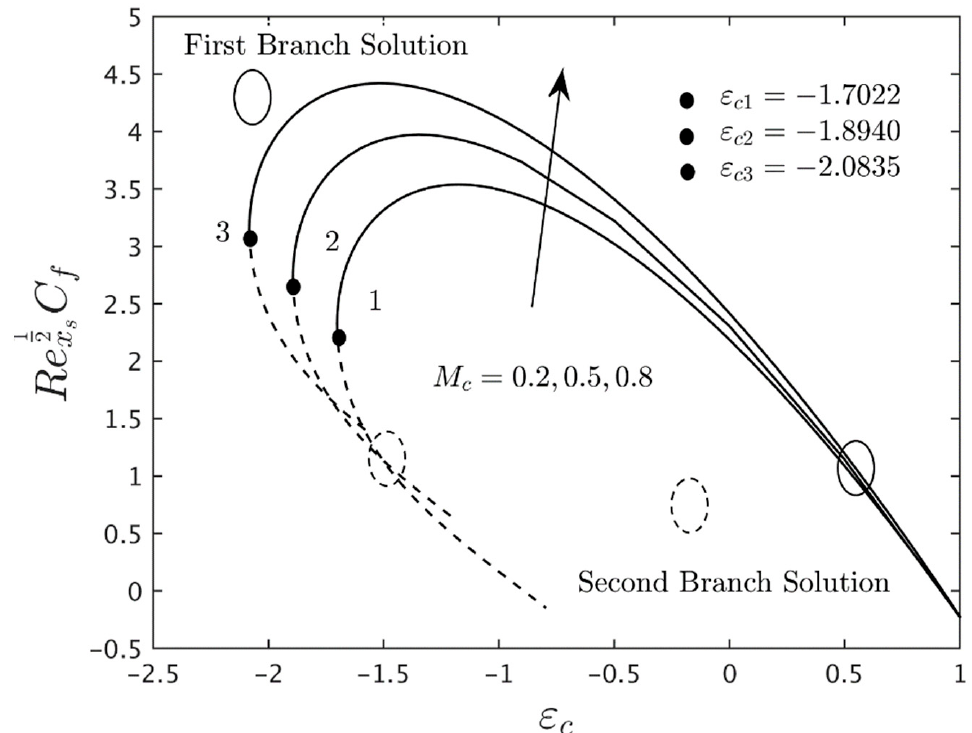
for the several values of c